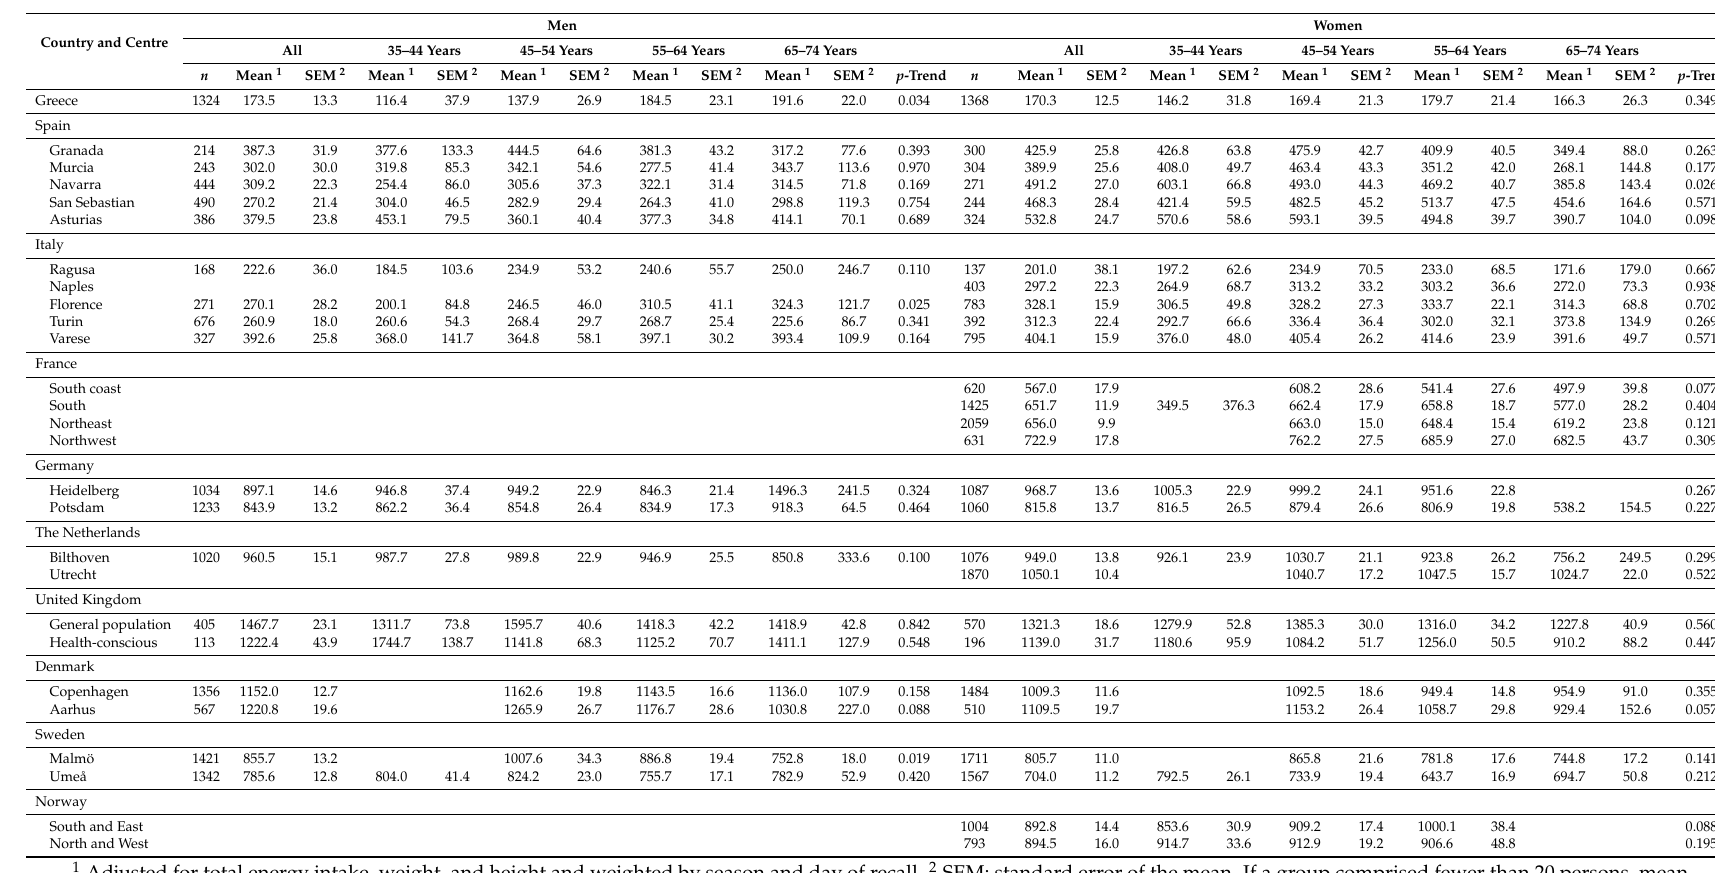
Table 3. Fully adjusted mean 1 daily intake of coffee and tea (g/day) by age group and sex in the EPIC calibration study population based on 24-H Dietary Recall across EPIC centres ordered from south to